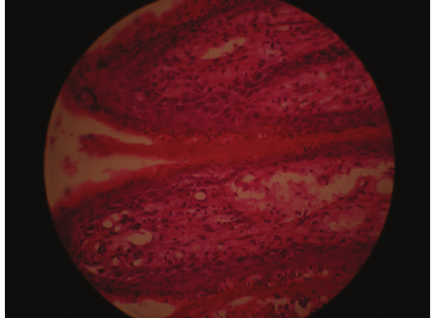
Figure 1: Clinical photograph showing the exophytic lesion on the left buccal mucosa.